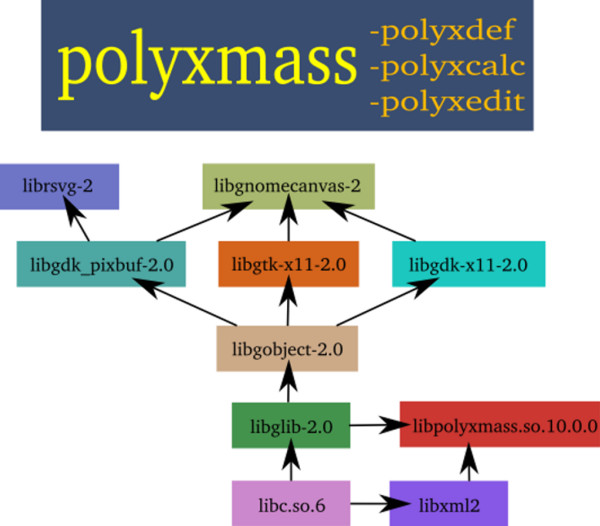
Software dependencies of the GNU polyxmas project. The libpolyxmass library has few dependencies while the polyxmass program has more dependencies due to its use of a number of graphical libraries for the window system and the graphical rendering of the polymer sequence.